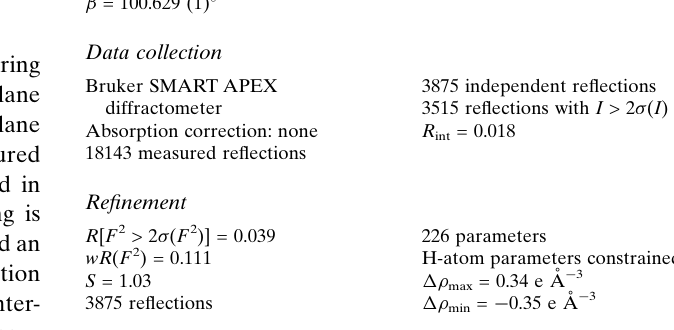
Data collection Bruker SMART APEX diffractometer Absorption correction: none 18143 measured reflections